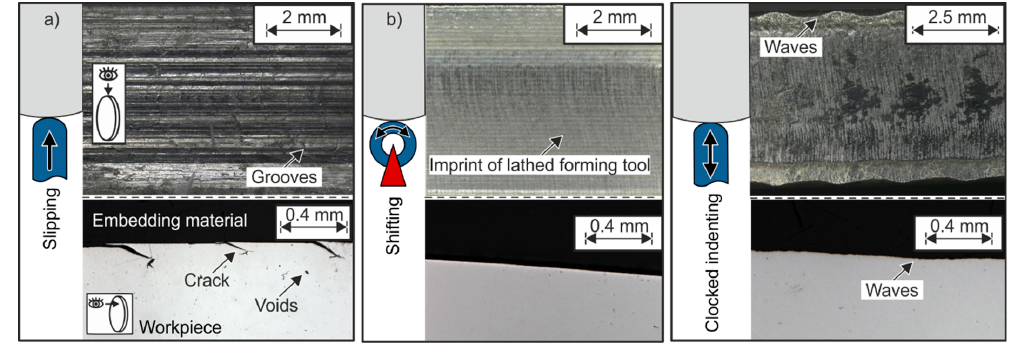
Figure 5. Characteristic influence of the ( a ) slipping, ( b ) shifting and ( c ) clocked indenting edge thickening processes on the macro- and microscopic surface quality of sheets made of